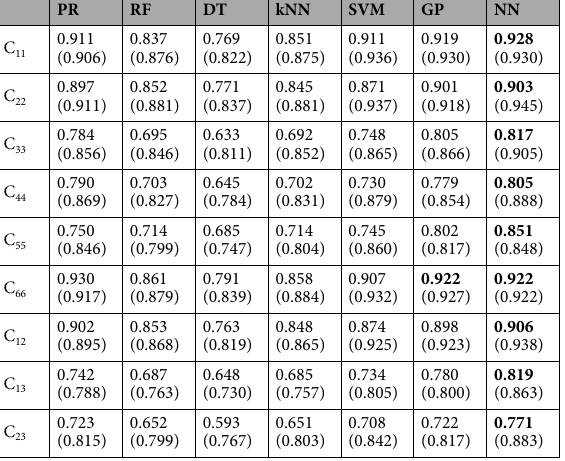
Table 2. Comparison of R 2 values provided by ML algorithms for the training (value inside the parentheses) and test